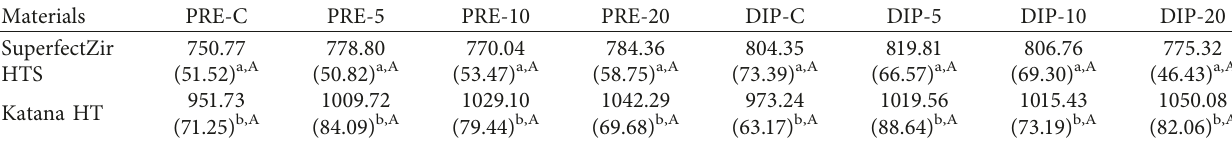
Table 3: Means and standard deviations of the flexural strength (MPa) for each group.